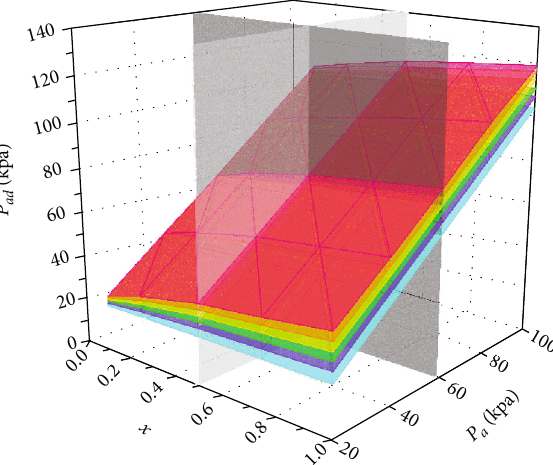
Figure 11: Relation of balance diaphragm pressure P relative valve opening x and ambient pressure P a . ad and